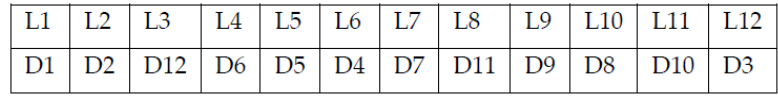
Figure 2. Gene representation in terms of locations and departments